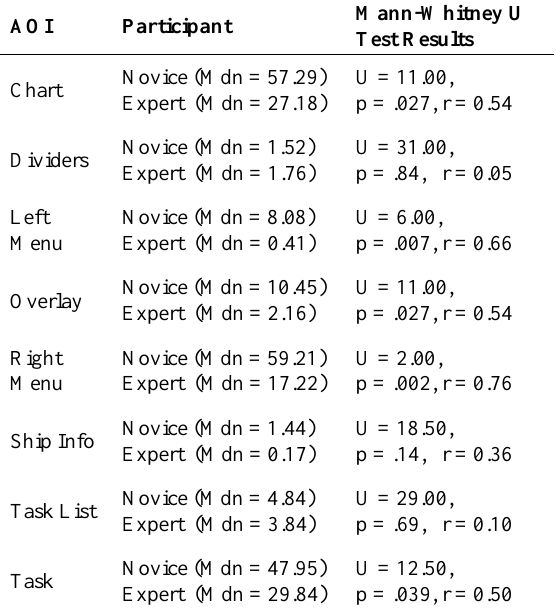
Table 4. Mann-Whitney U Test Results for total fixation dura- tions of novice and expert participants on ecdis exercise.